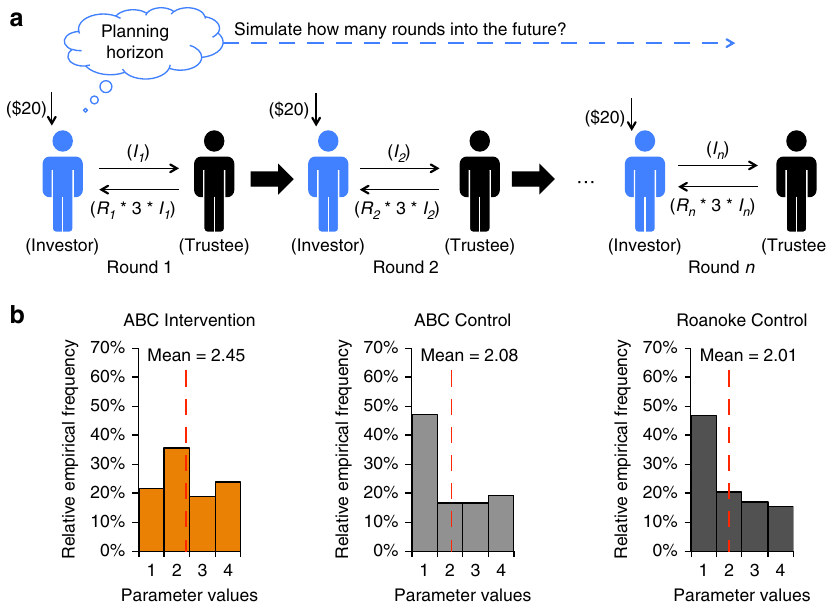
Fig. 4 The Planning horizon in the multi-round trust game (MRT). a In each round, the Investor (played by the participant; indicated in blue) received $20 and decided how much of it to send to the Trustee (played by a computer algorithm; indicated in black). The amount ( I ) the Investor sent was tripled and delivered to the Trustee, who decided what fraction ( R ) of this total (3* I ) to send back to the Investor. The Investor ended up with 20- I + R *3* I ; the Trustee with (1- R )*3* I . Planning horizon quanti fi es how many steps of the future interactions the participant took into account when assessing the results of his/her investment during the MRT. b Distribution of the future planning capacity parameter (planning horizon) in ABC Intervention, ABC Control, and Roanoke Control group,